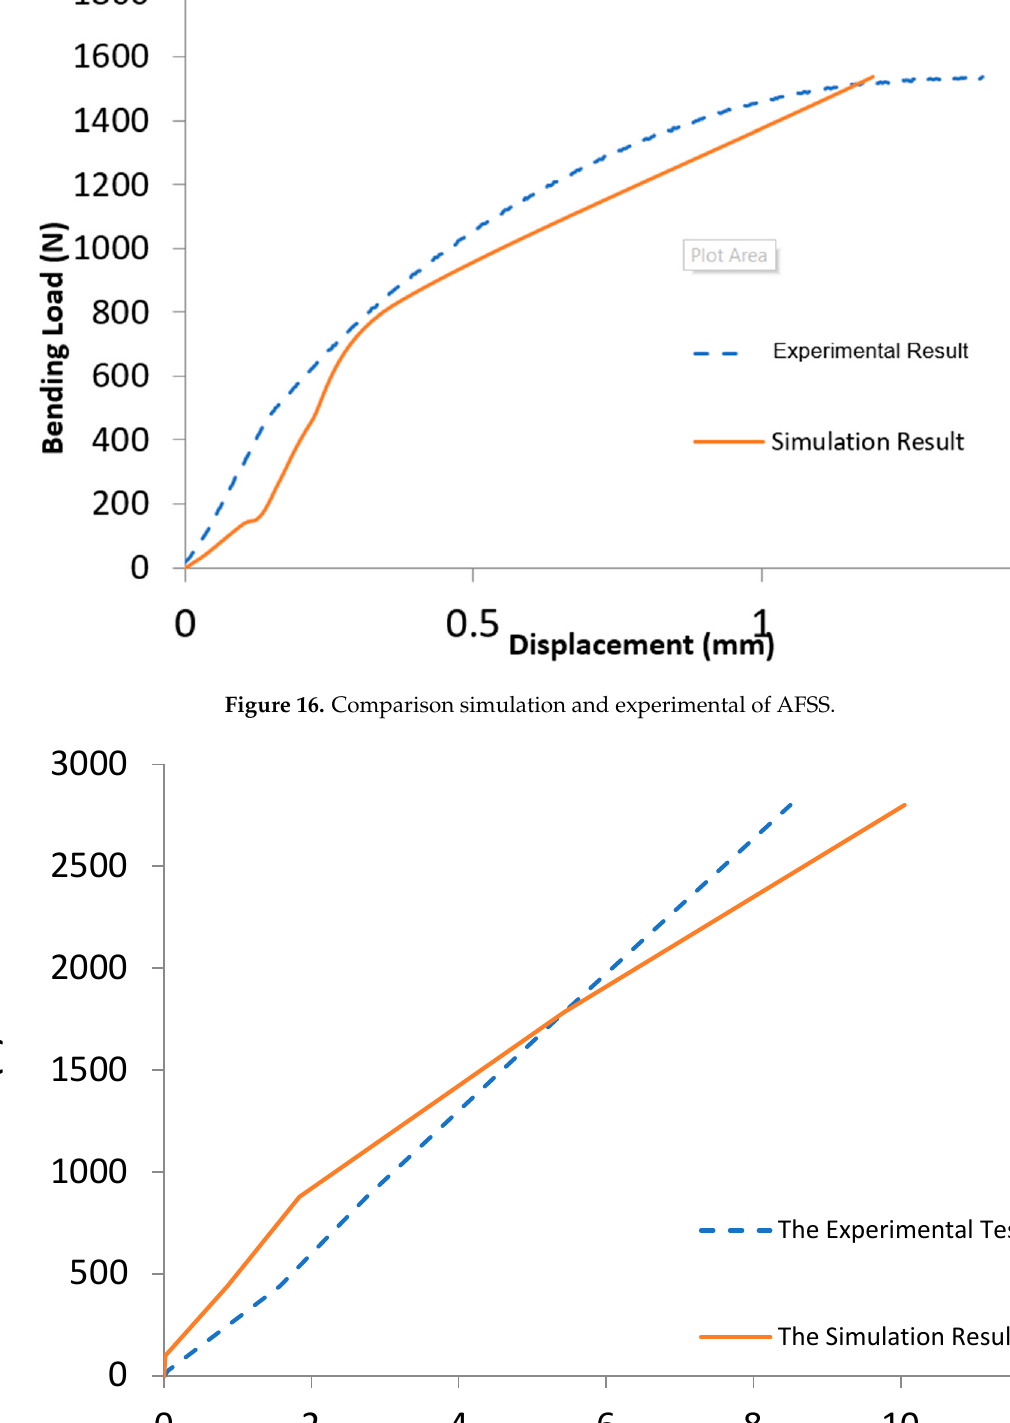
Figure 17. Comparison between simulation and experimental of AFSS wrapped around